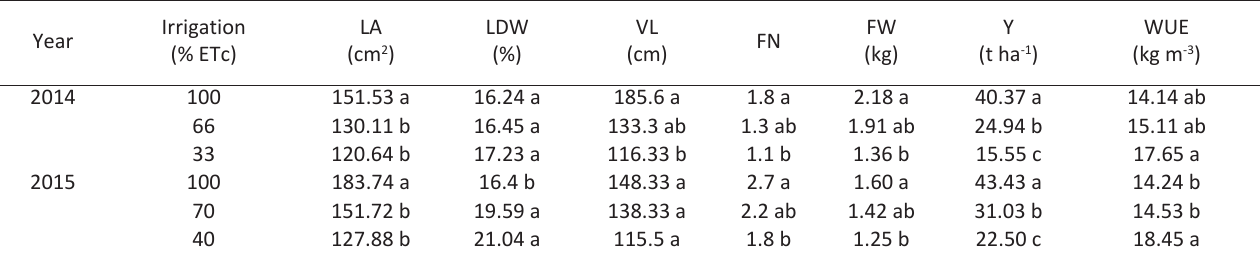
I 33 , I 40 , I 66 , I 70 and I 100 represent the irrigation treatments that received 33, 40, 66, 70 and 100% of ETc, respectively. Values are the ave- rage of 10 observation of each replication per irrigation level. Within each column, values followed by the same letters are not significan- tly different